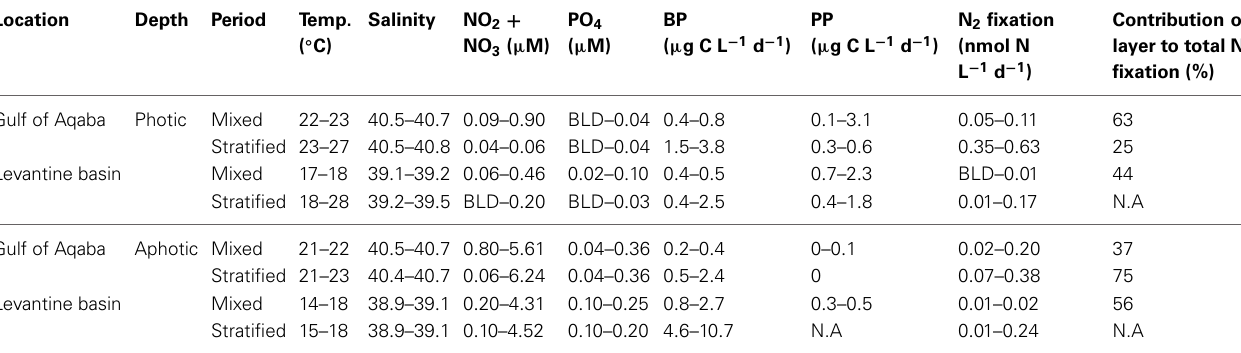
Table 2 | Measured physical, chemical, and biological properties of the photic and aphotic layers from the sampling stations in the Levantine basin and the Gulf of Aqaba averaged seasonally for when the water column was mixed (winter) and during thermal stratification (spring, summer, and